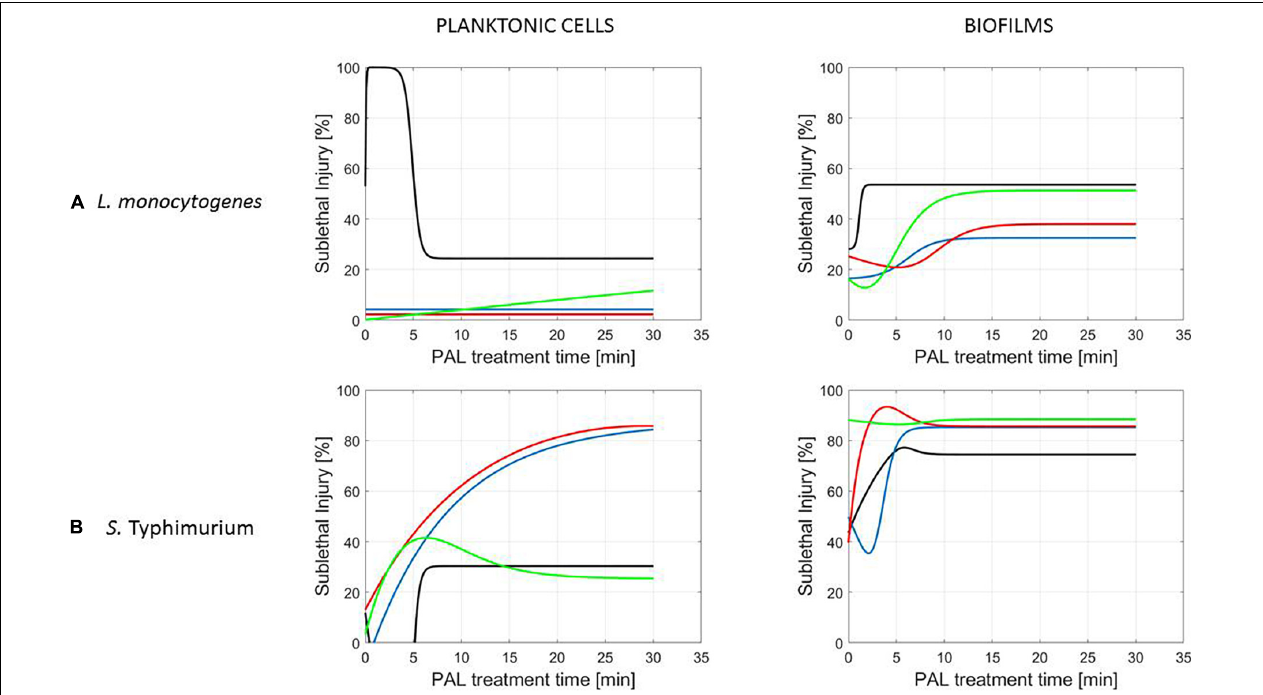
FIGURE 7 | Evolution with time of the sublethal injury (%) of (A) L. monocytogenes or (B) S. Typhimurium planktonic cells and biofilms toward the plasma activated liquid treatment time using solutions of different ages (0, 3, 10, and 30